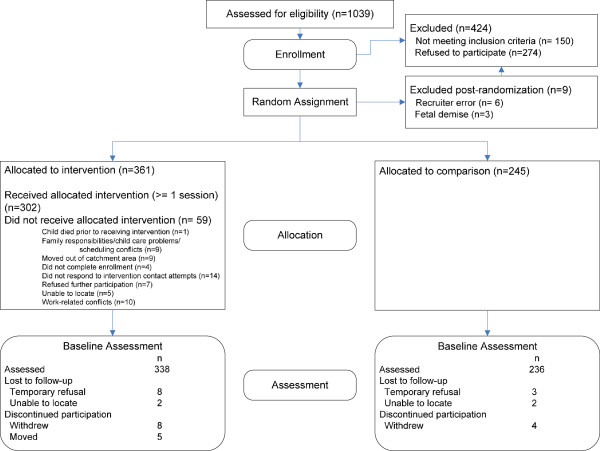
CONSORT Flowchart for the Legacy for ChildrenTM project.